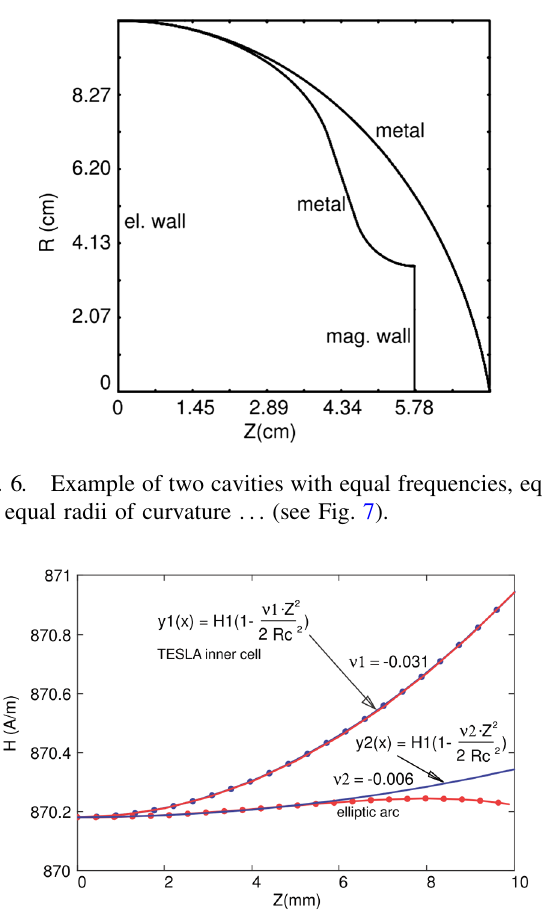
FIG. 7. (See Fig. 6) . . . but different behavior of fields near the